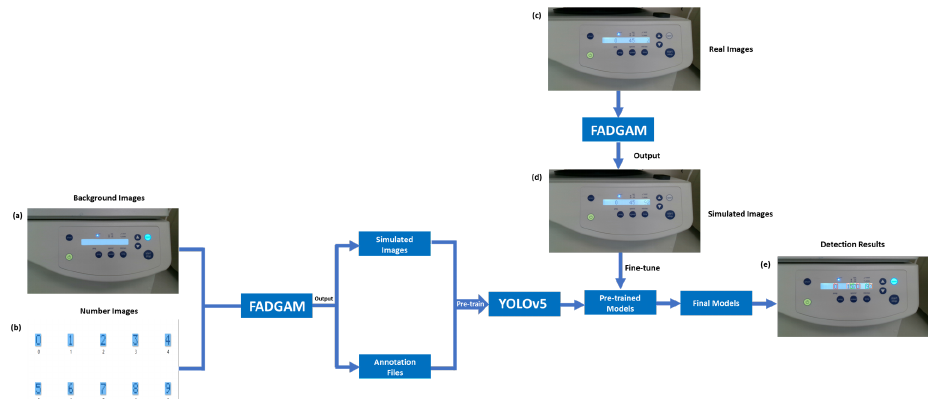
Figure 1. A flow chart of FLIMM. ( a ) Background Images. ( b ) Number Images. ( c ) Real images. ( d ) Simulated Images. ( e ) Detection results.